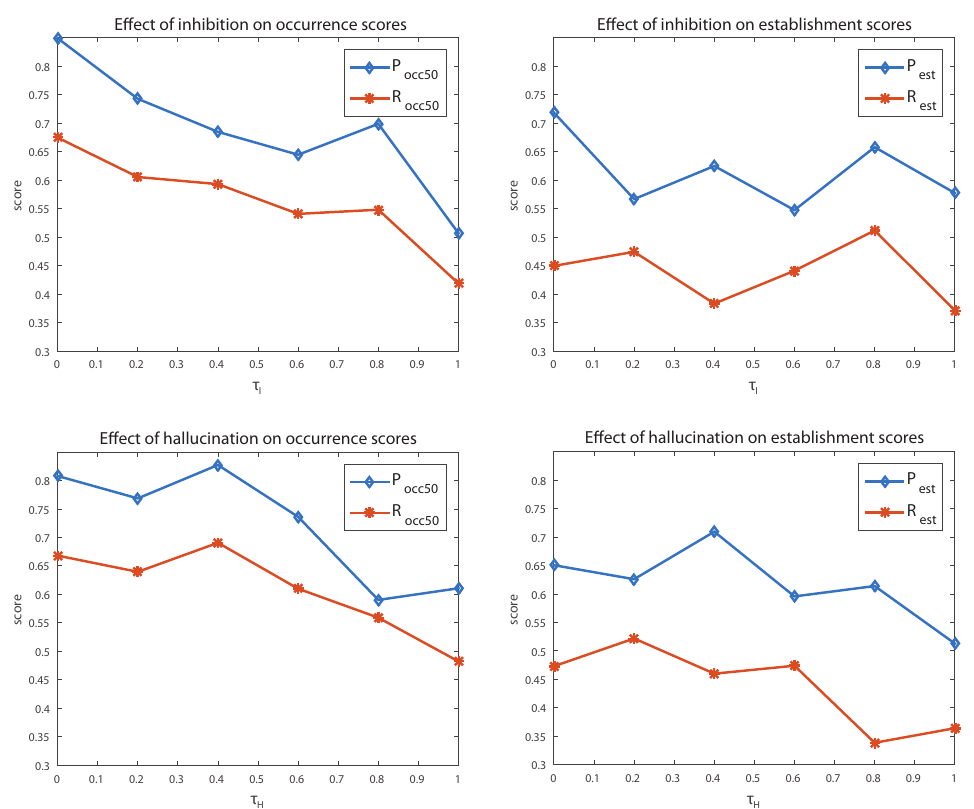
Figure 2. Sensitivity of the model to changes of the hallucination parameter τ I ( top ) and the inhibition parameter τ H ( bottom ). When one parameter was varied, all others remained